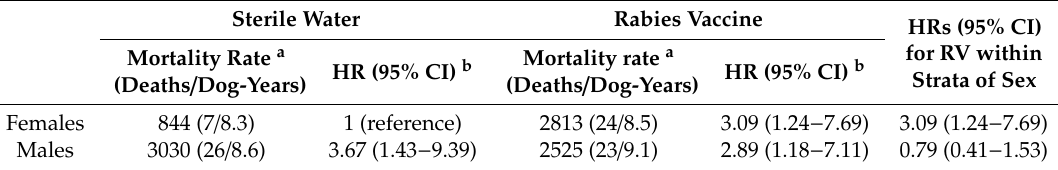
Figure 3. Survival curve of study subjects ( n = 358) by group and sex, from 6 weeks to 13 weeks of age (time 0 = day of 1st injection). SW = sterile water (control); RV = rabies vaccine. Table 4. All-cause mortality from 6 weeks to 13 weeks of age by group allocation and sex for 358 puppies randomly allocated to receive subcutaneous injection of sterile water ( n = 179) or rabies vaccine ( n = 179) at 6 weeks of age.